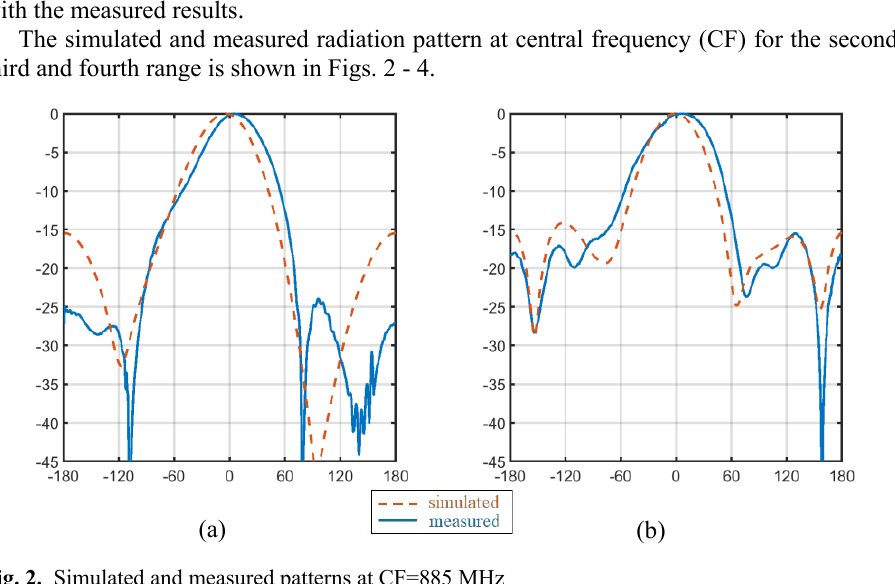
Fig. 2. Simulated and measured patterns at CF=885 MHz